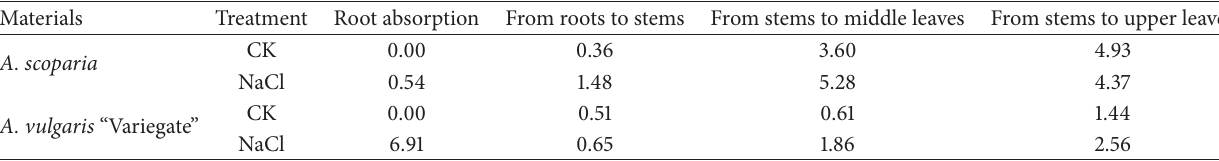
Table 10: Effect of NaCl stress on absorbing and transporting selectivity ratios of Mg 2+ to Na + in seedlings.